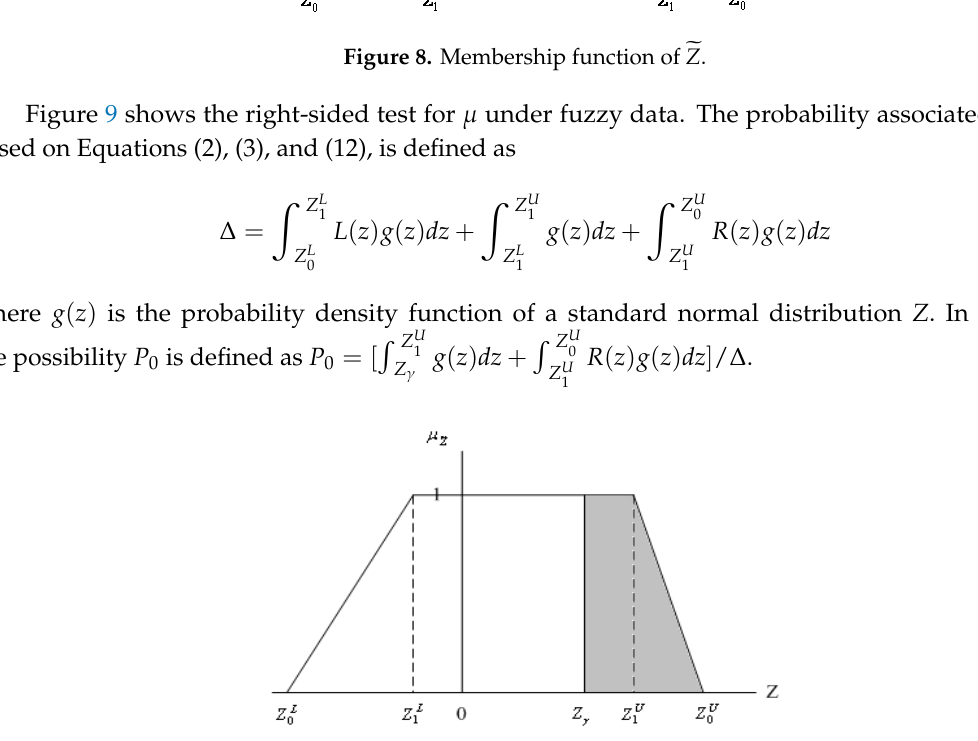
Figure 9. The right-sided test for µ under fuzzy data .